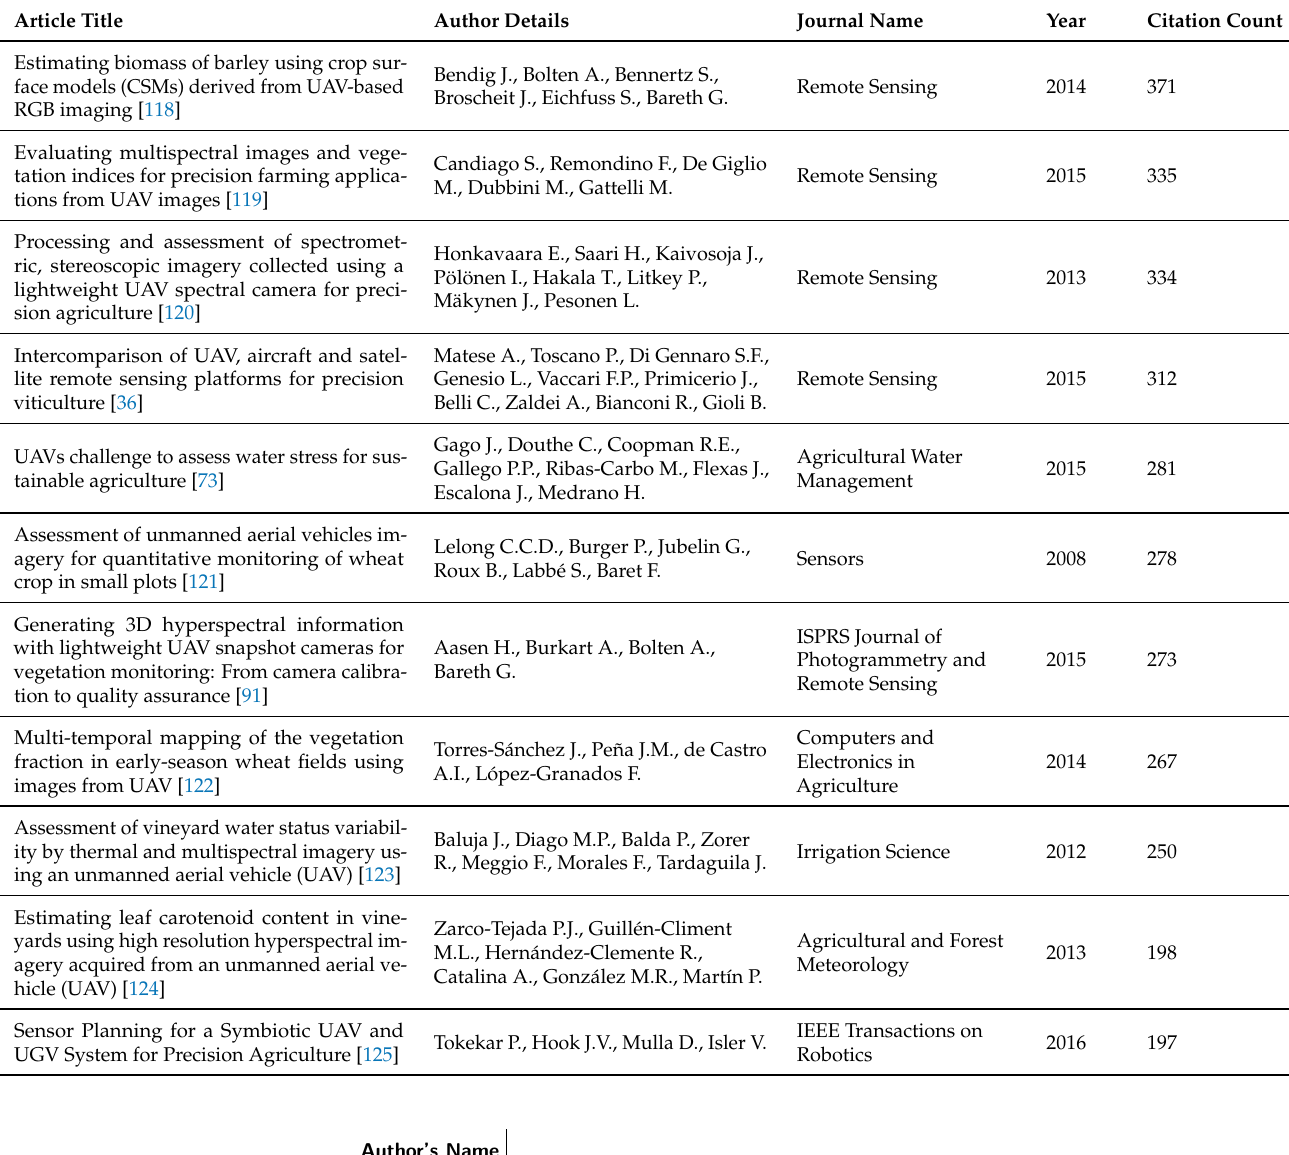
Table 2. Most cited documents on adopting UAV-PA.